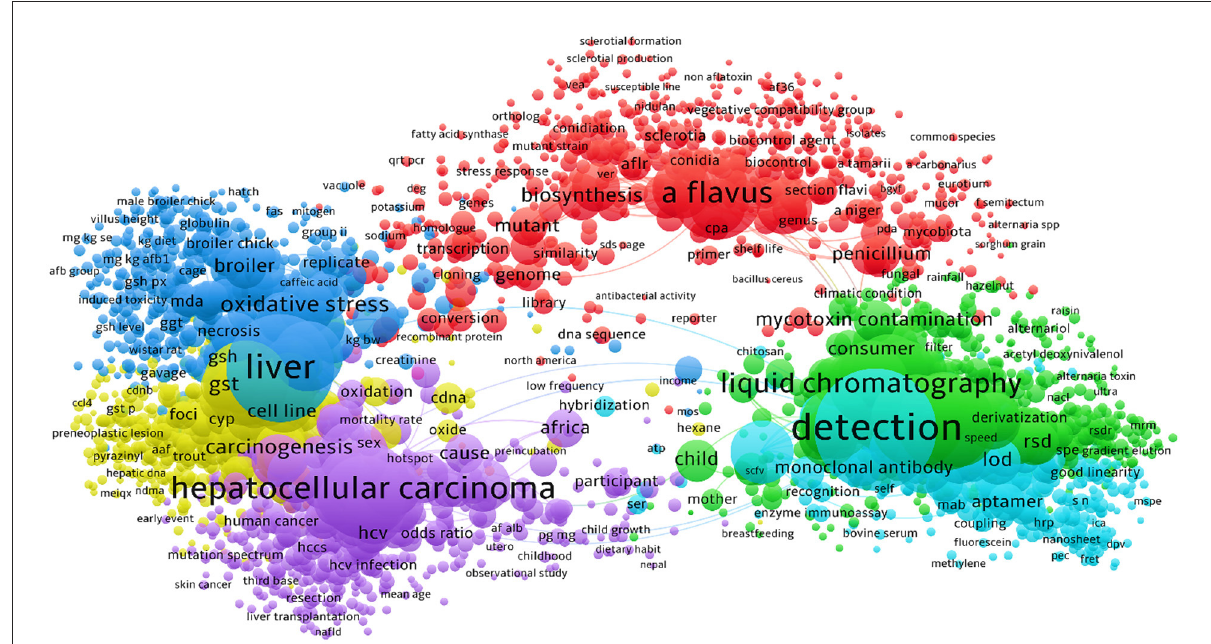
FIGURE5 The bibliometric network of studies on AFs from 1990 to 2021 in scientific databases. As detailed in this figure, the majority of studies have been targeted the technical methods to identify the AFs contaminants in suspected samples. Research on carcinogenic effects of AFs was also occupied a large proportion of studies in this